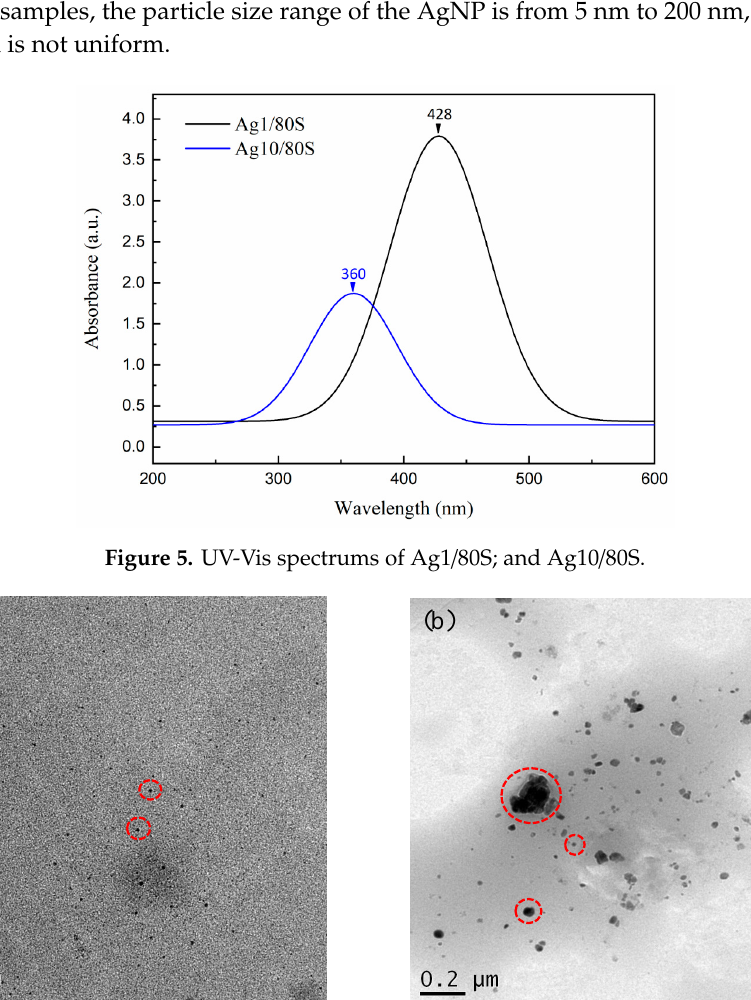
Figure 6. TEM images of (a) Ag1/80S; and (b) Ag10/80S. (Within each red circle is a single AgNP.)